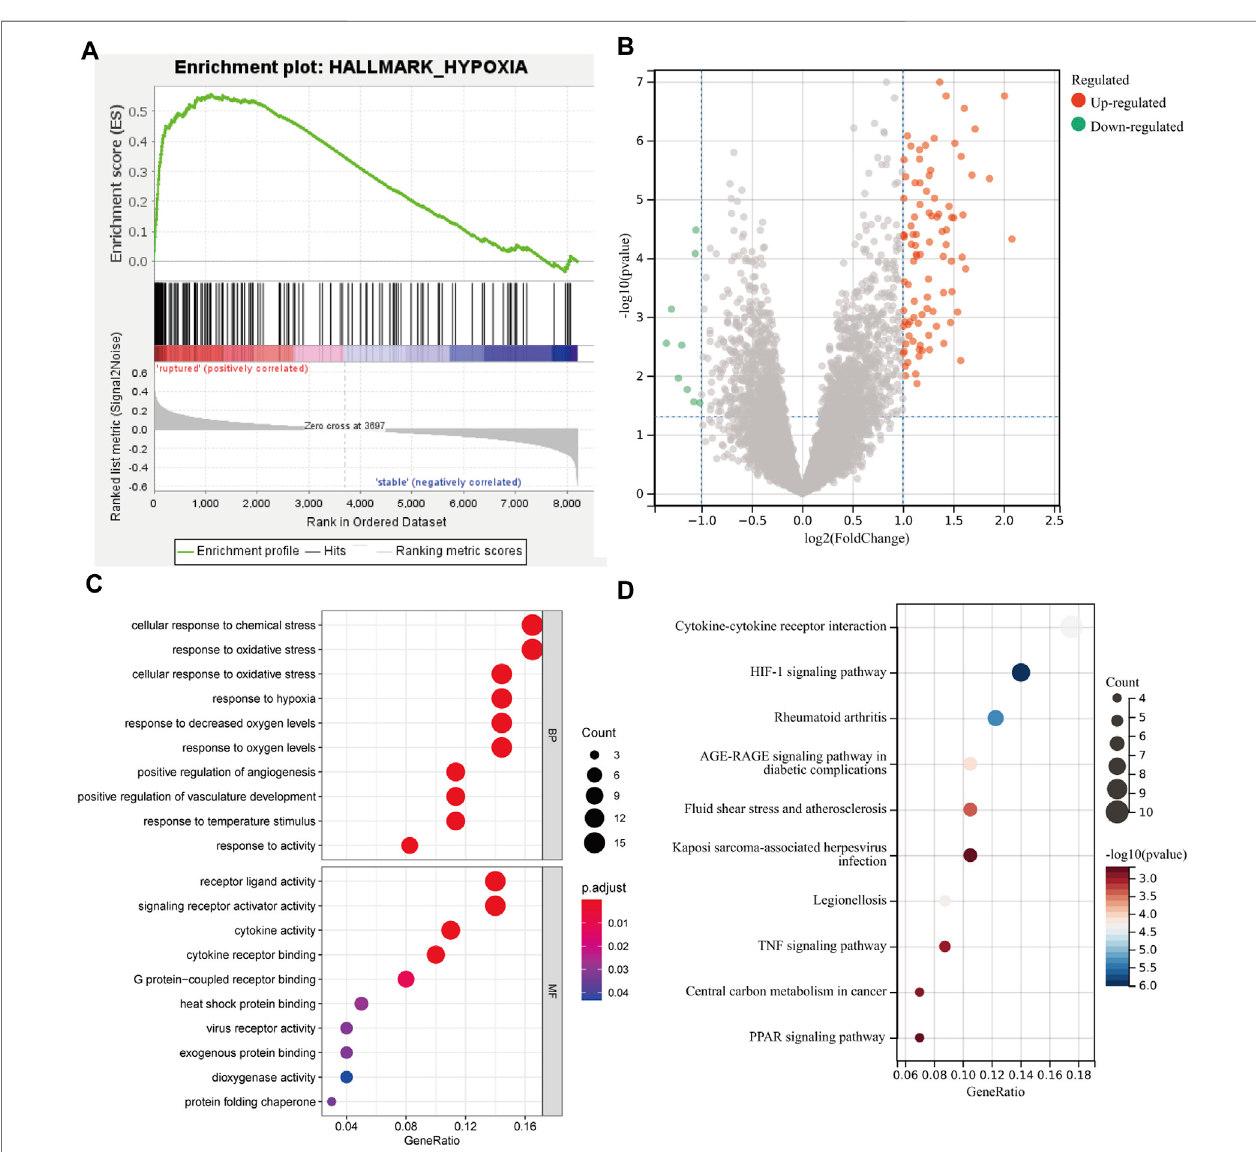
FIGURE2| DifferentialandfunctionalenrichmentanalysesofhypoxicstatesinAAA. (A) GSEAshowedahighenrichmentofhypoxicgenesetsintherupturegroup. (B) Thescatter plotshows theDEGsbetweenthehigh and lowhypoxiascoringgroups. (C) Bubbleplotofthe top10GOpathways bybiologicalprocess and molecular function. (D) Bubble plot of the top 10 KEGG pathways enrichment analysis for molecular function.